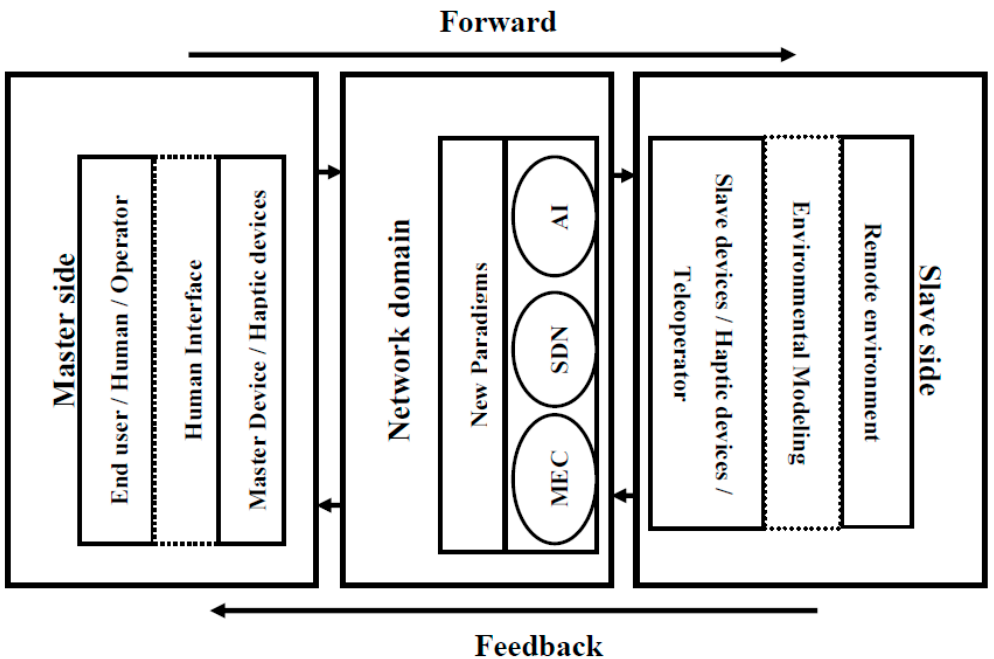
Figure 1. General structure of the tactile Internet system.